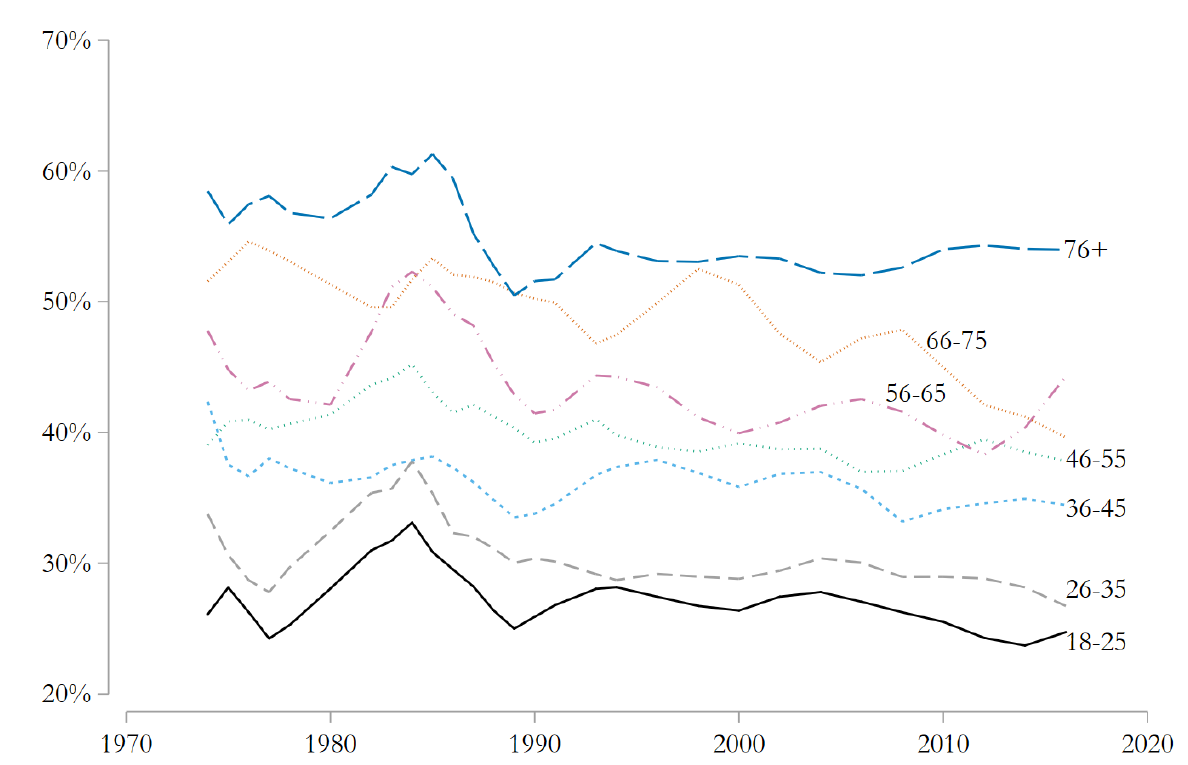
Figure 2: Strong affiliation by age group over time (locally weighted regression lines), General Social